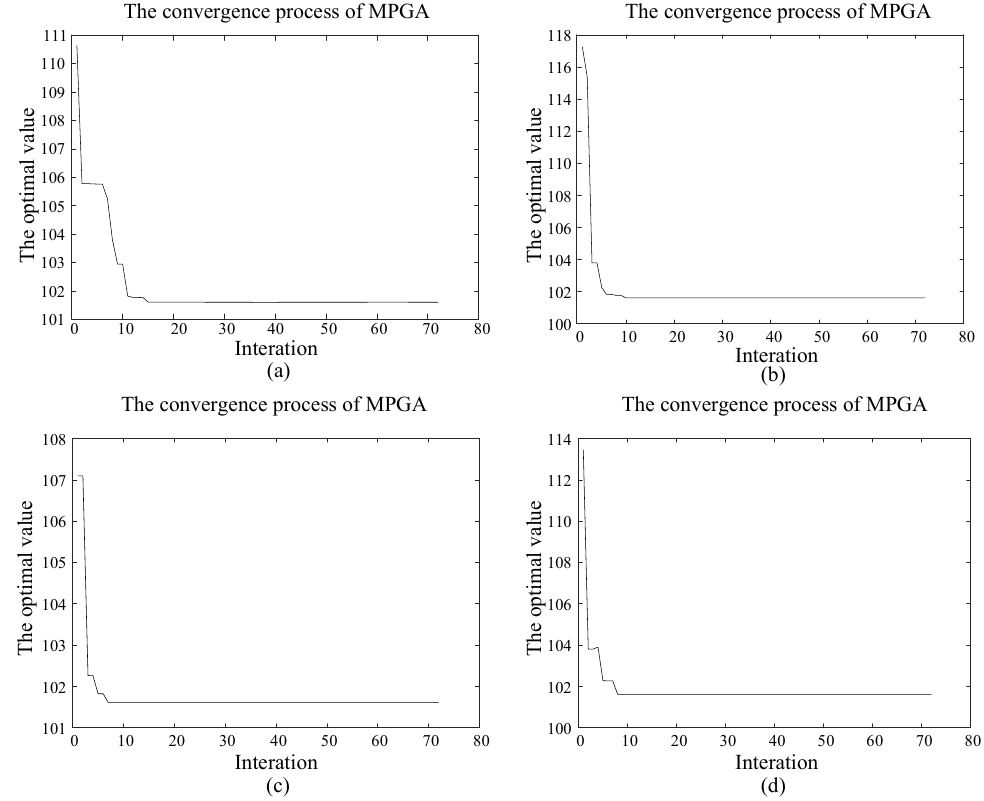
Fig. 11. The convergence curve of the objective values for Case 3 The optimal results for different